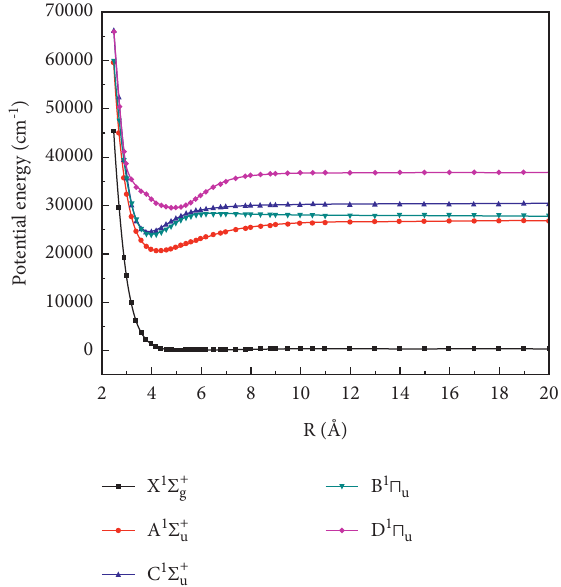
Figure 1: The calculated potential energy curves (PECs) at the icMRCI +Q/ECP60MDF/32213220 level. Table 1: The spectroscopic parameters of calculated and experimental values of Yb